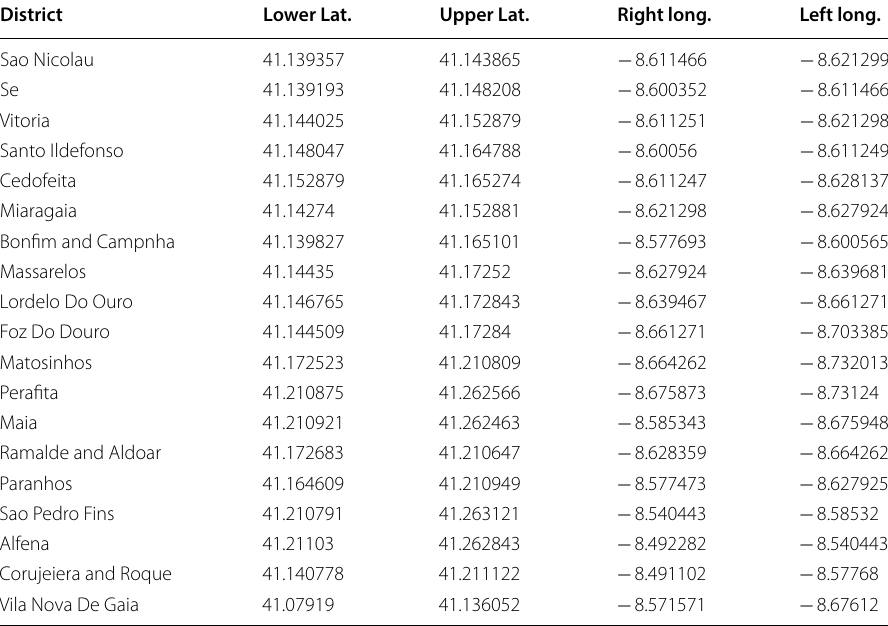
Table 2 Porto city districts border coordinates District Lower Lat. Upper Lat. Right long. Left long. Sao